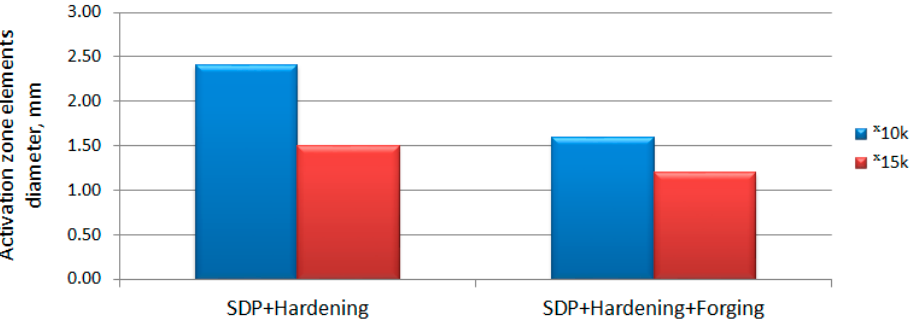
Figure 15. Diameter of activation zone elements of W6Mo5Cr4V2 steel samples (magnification 10,000, magnification 15,000).